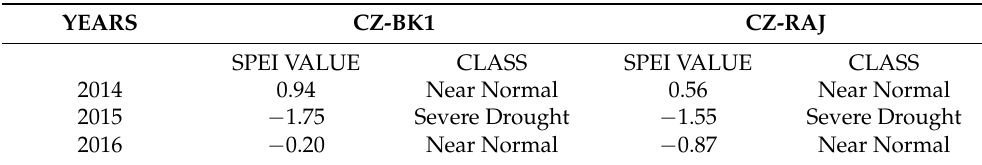
Table 4. Categorization of dryness/wetness using Standardised Precipitation-Evapotranspiration Index (SPEI) indices for CZ-BK1 and CZ-RAJ stations in years